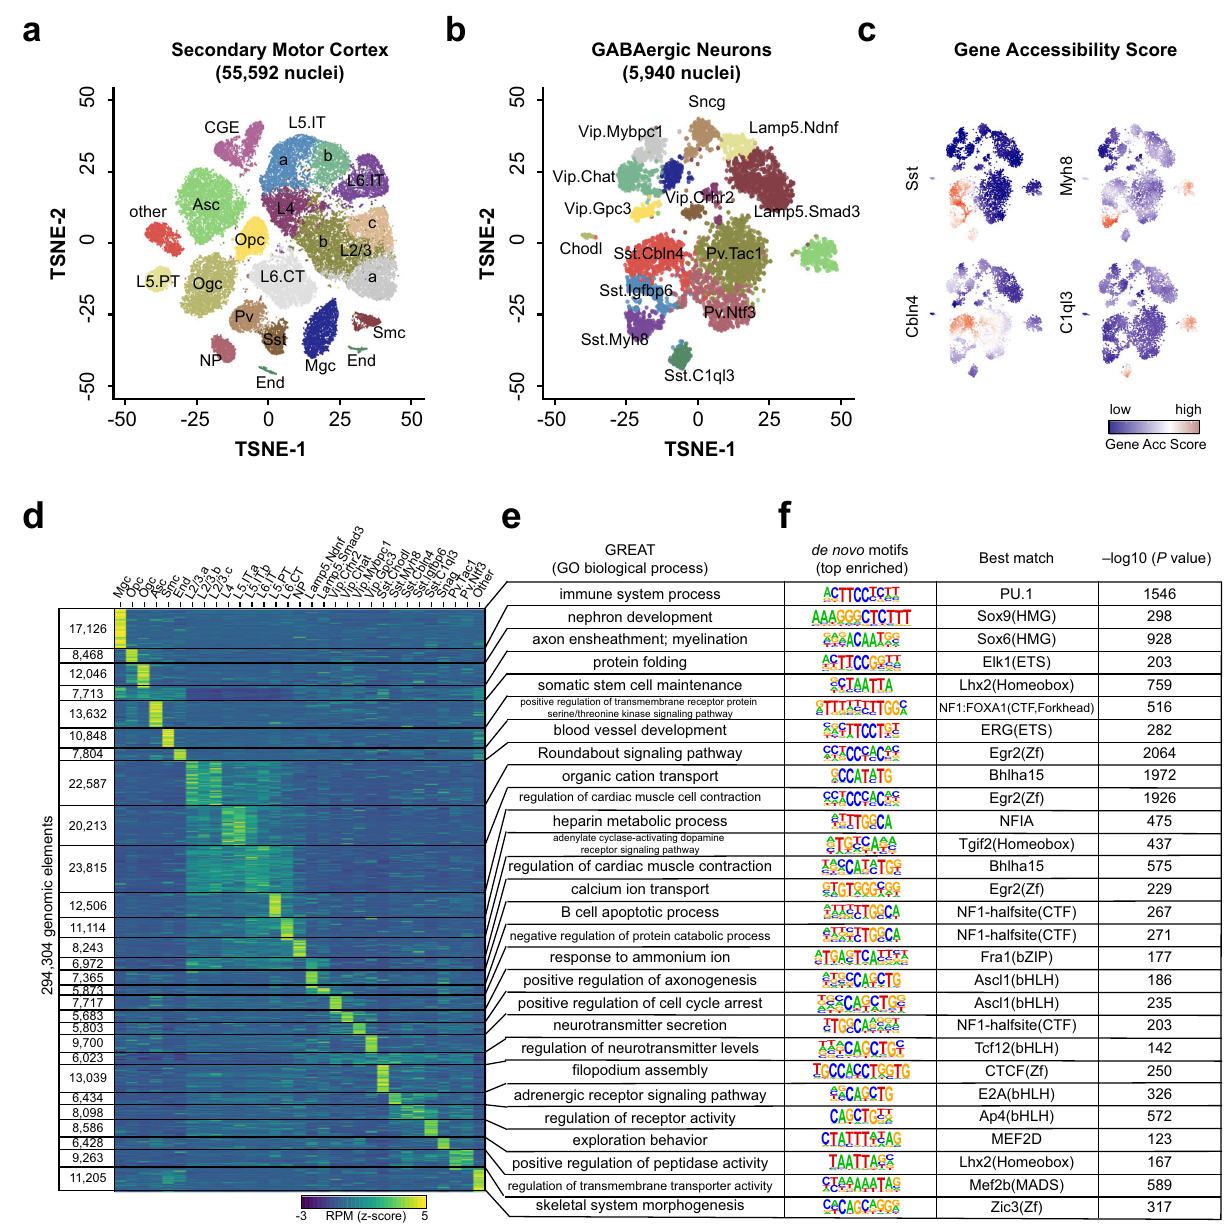
Fig. 5 A high-resolution cis -regulatory atlas of mouse secondary motor cortex (MOs). a T-SNE visualization of 20 major cell types in MOs identi fi ed using SnapATAC. b Fourteen GABAergic subtypes revealed by iterative clustering of 5940 GABAergic neurons (Sst, Pv, and CGE in a ). c Gene accessibility score of canonical marker genes for GABAergic subtypes is projected onto the t-SNE embedding. d k -means clustering of 294,304 differentially accessible elements based on chromatin accessibility. e Gene ontology analysis of each cell-type predicted by GREAT analysis 27 . f Transcription factor motif